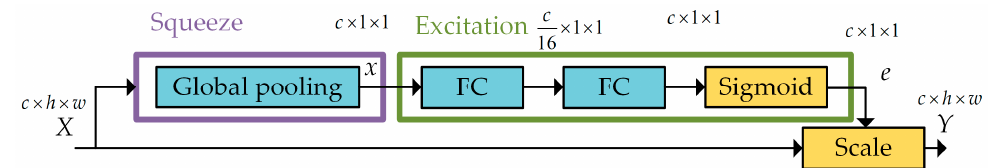
Figure 5. The architecture of the SEM. The purple frame indicates the squeeze operation, and the green frame indicates the excitation operation. FC denotes the fully connected layer. The number of neurons in the first and second fully connected layer is set to c / 16 and c , as suggested in [11]. The input is indicated as X , and the output is denoted by Y .